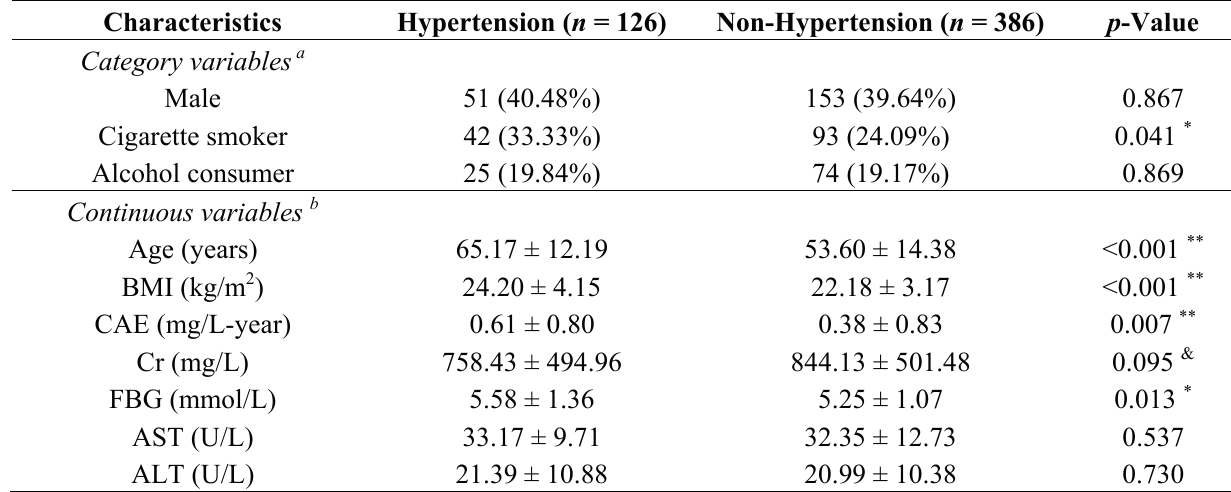
Table 1. Baseline characteristics of hypertension and non-hypertension subjects from arsenic-endemic area in Inner Mongolia, China ( n =